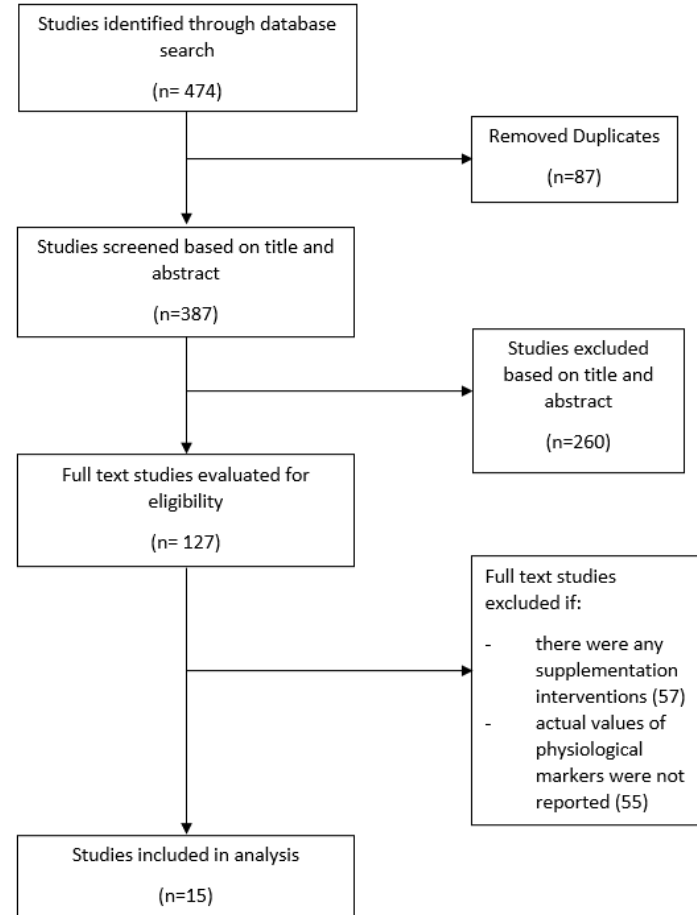
Figure 1. PRISMA flow diagram of the search procedure used for this narrative review.